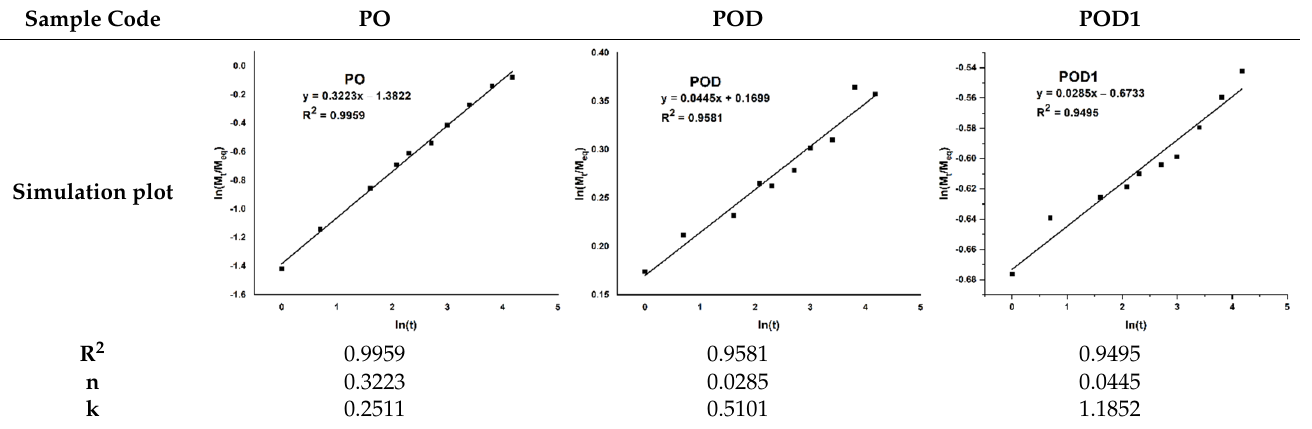
concentration gradient; (ii) when 0.5 < n < 1 , the abnormal Fickian diffusion is dominant,